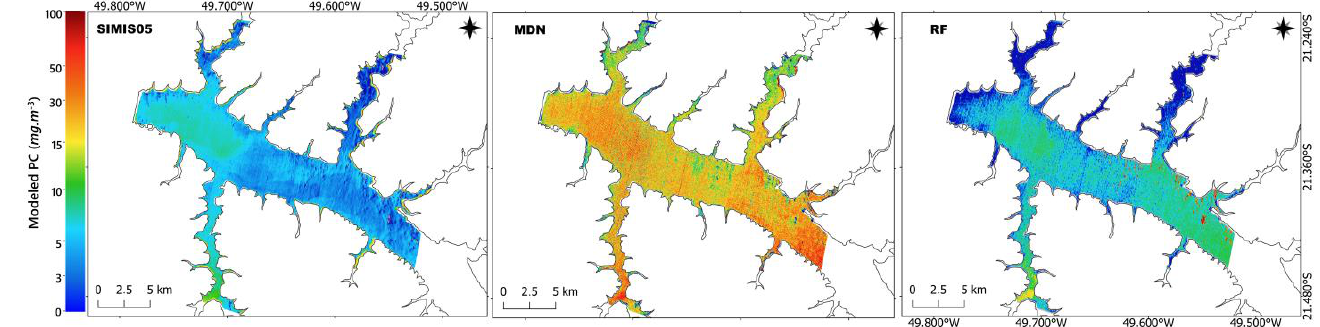
Figure 8. PC product maps of Promissão Reservoir on 3 October 2021 produced by the Simis et al. (2005) model and ML algorithms (MDN and RF) applied on the PRISMA L2C+WS07 image. The PC mapping from OLCI/ACOLITE images (Figure 9) agreed with PRISMA PC Table 5. In situ measured PC (mg.m − 3 ) compared against retrieved PC (mg.m − 3 ) from PRISMA and OLCI images for 3 October 2021. The spatial distribution of the labeled stations is shown in Figure 9. PRISMA OLCI Station In Situ